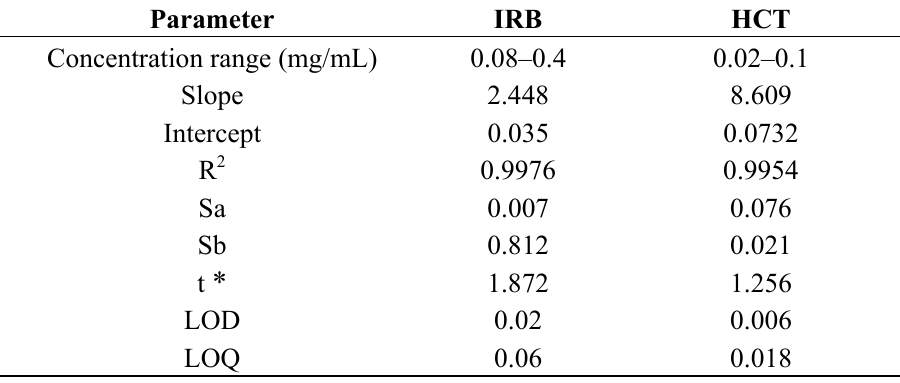
Table 8. Statistical parameters for individual calibration curves.